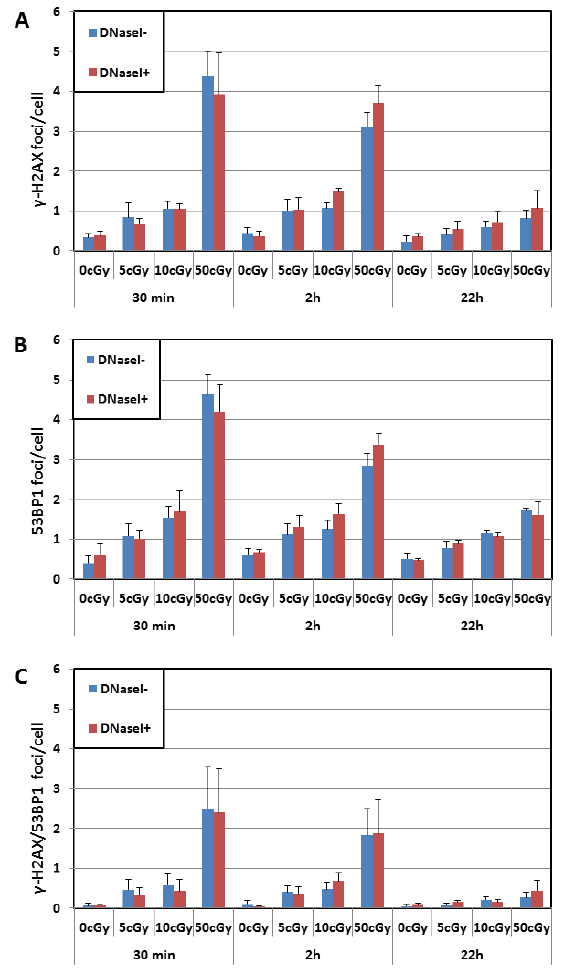
Statistically significant values are marked red.